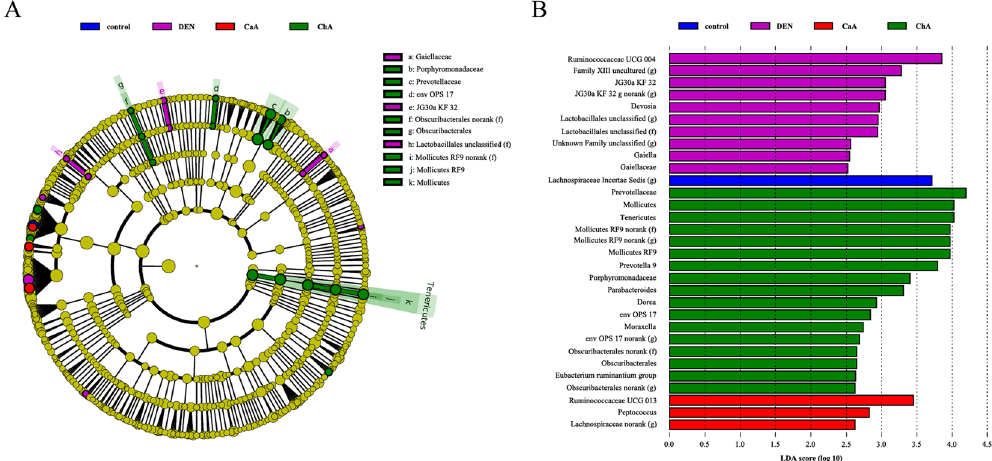
Figure 4. Discriminative taxa of fecal microbiota among control, DEN, DEN + CaA and DEN + ChA group. ( A ) Cladogram representing the features that are discriminative among these groups using the LDA model results on the bacterial hierarchy. Significantly discriminant taxon nodes are colored and branch areas are shaded according to the highest-ranked variety for that taxon. For each taxon detected, the corresponding node in the taxonomic cladogram is colored according to the highest-ranked group for that taxon. If the taxon does not show significantly differential representation between sample groups, the corresponding node is colored yellow. ( B ) LDA coupled with effect size measurements identifies the most differentially abundant taxons among these